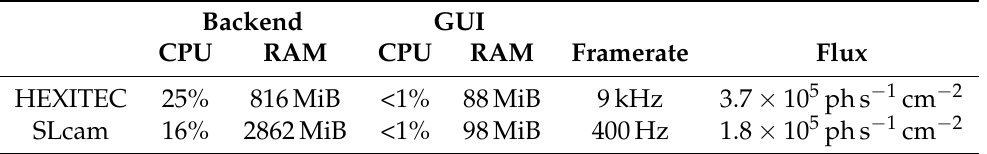
Table 2. Resource consumption by the SpeXIDAQ framework in active use, with a running mea- surement configured to include 4000 energy bins in the data cube output. The backend and GUI are listed separately, as the latter can be run on a different workstation, and has a high degree of variability in memory and CPU usage depending on viewing settings. All configuration and GUI settings are representative for a typical X-ray imaging experiment using a polychromatic lab source and optimised flux for low pile-up and acceptable